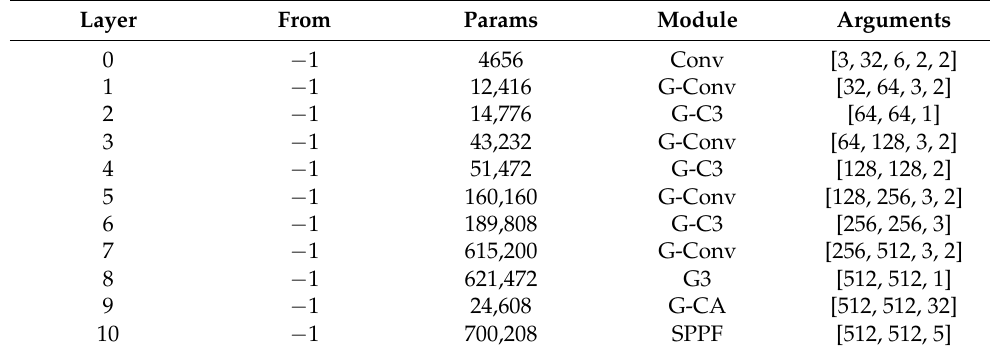
Table 1. G-Backbone network structure.